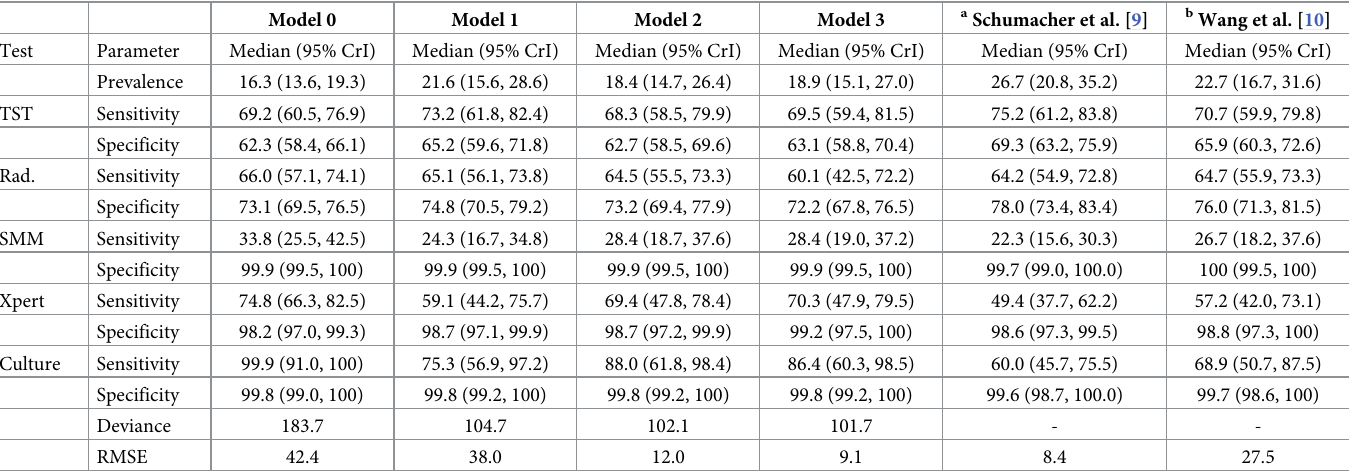
Table 2. Posterior median and 95% credible intervals (95% CrI) of the prevalence and diagnostic test sensitivity and specificity of the CPTB